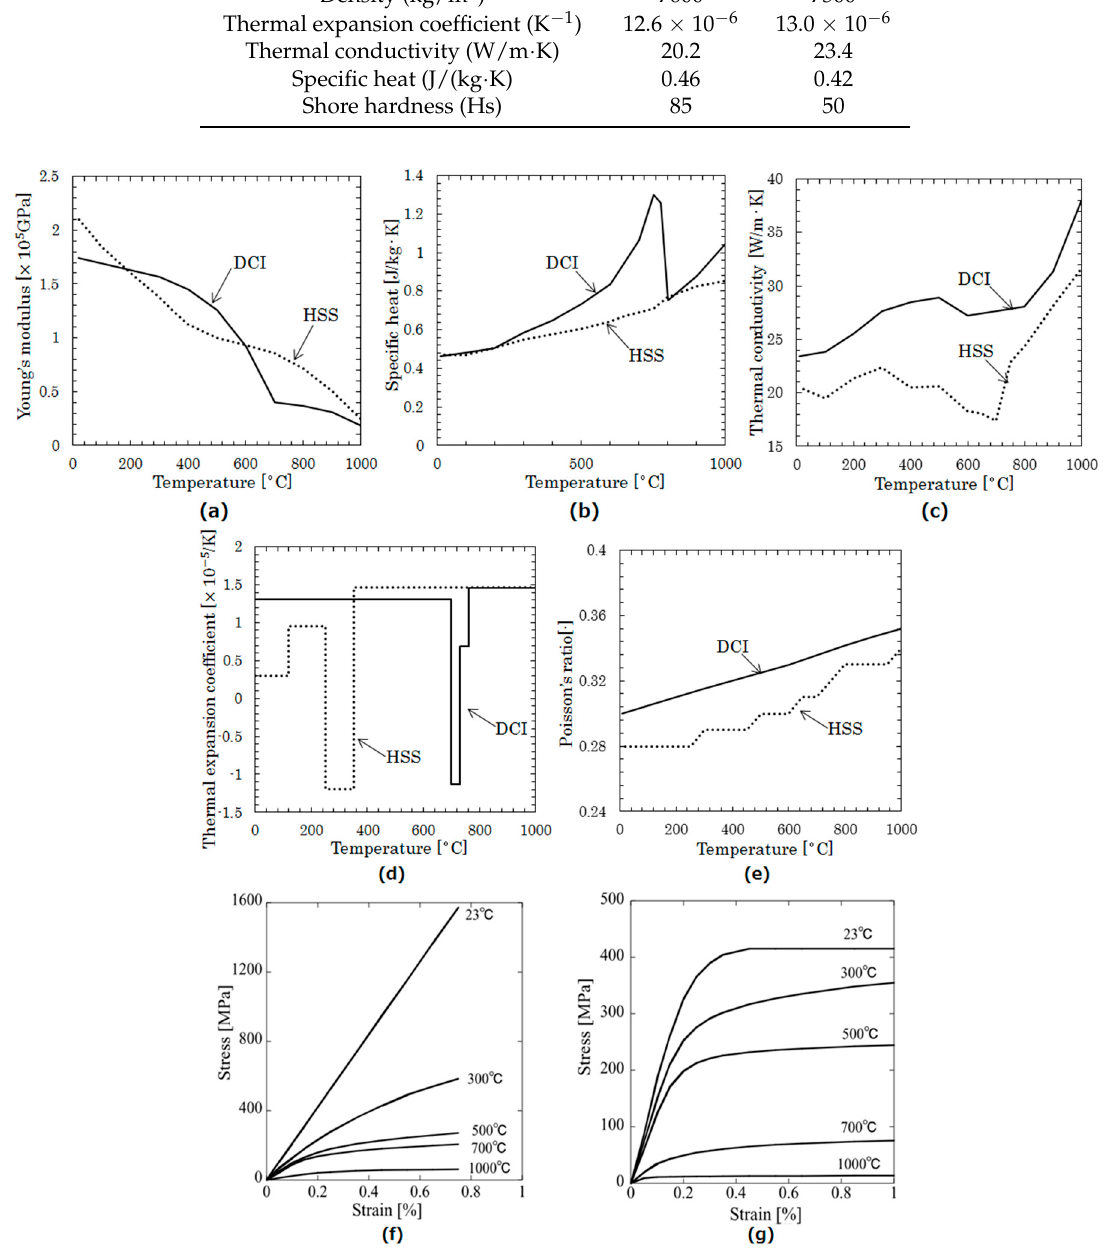
Figure 3. ( a ) Young’s modulus; ( b ) specific heat; ( c ) thermal conductivity; ( d ) thermal expansion coefficient during quenching; ( e ) Poisson’s ratio; ( f ) stress-strain for HSS; ( g ) stress-strain for DCI.